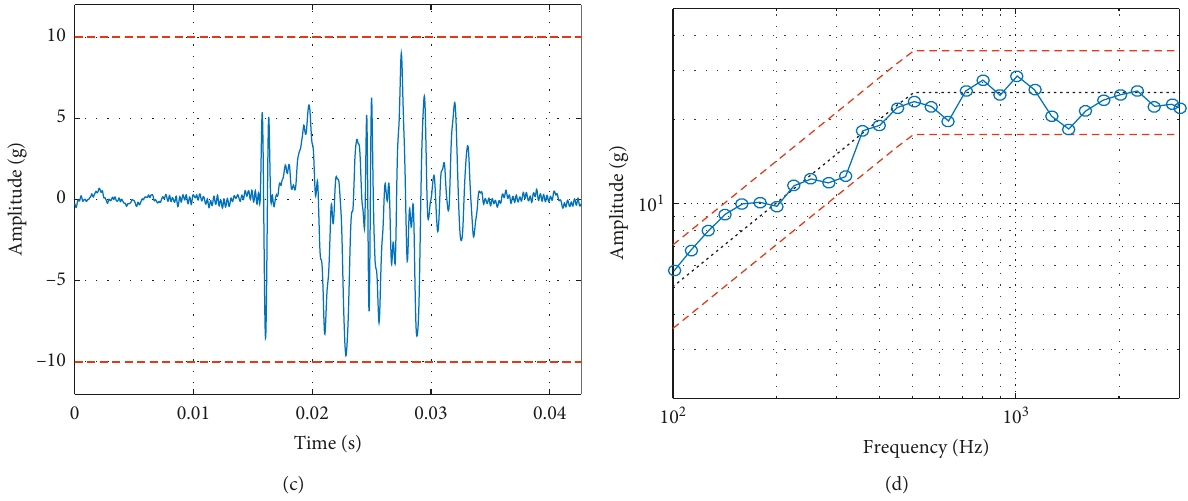
Figure 11: Case B: SRS experimental validation with light load. (a) Shaker; (b) FRF; (c) waveform; (d) SRS.